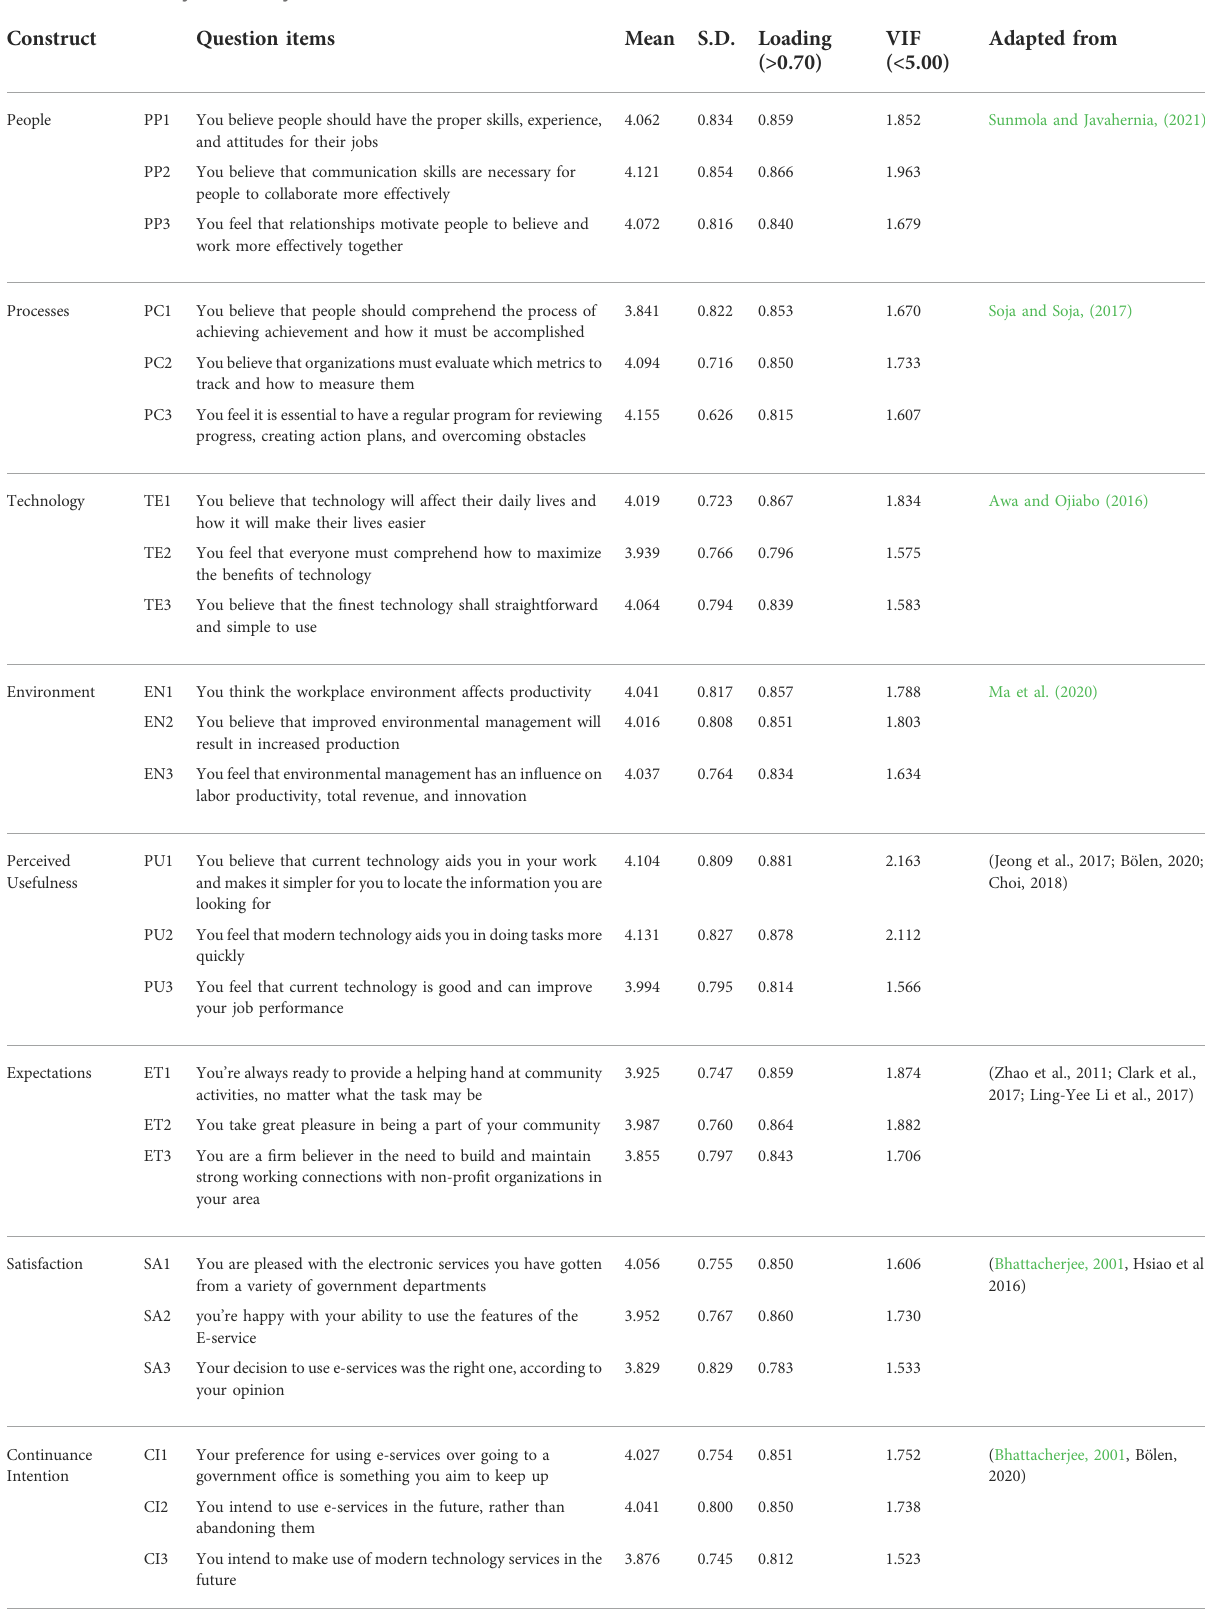
TABLE 3 The reliability and validity of the